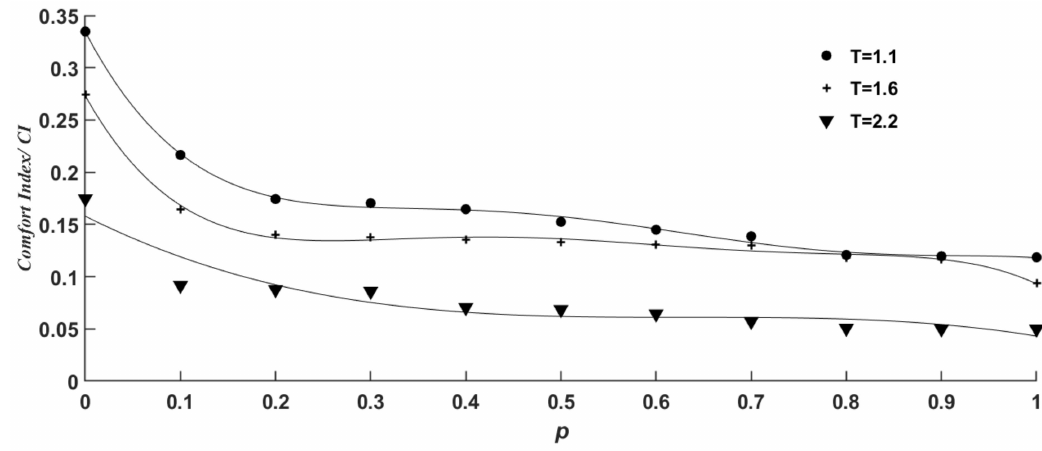
Figure 9. Scatter plot of PS-IDM comfort index.